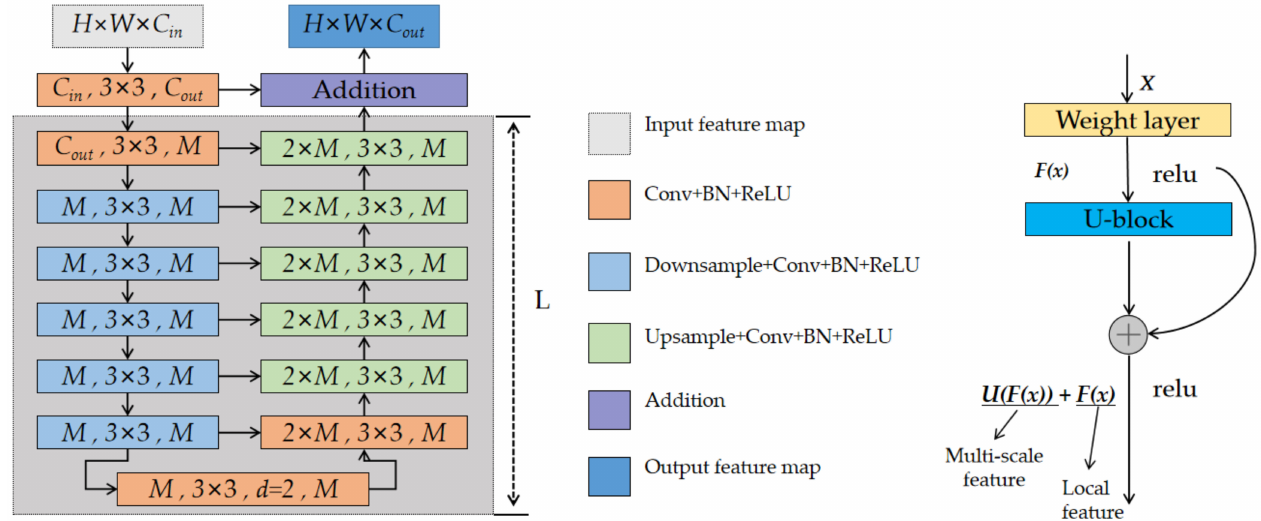
Figure 8. Structure of the residual